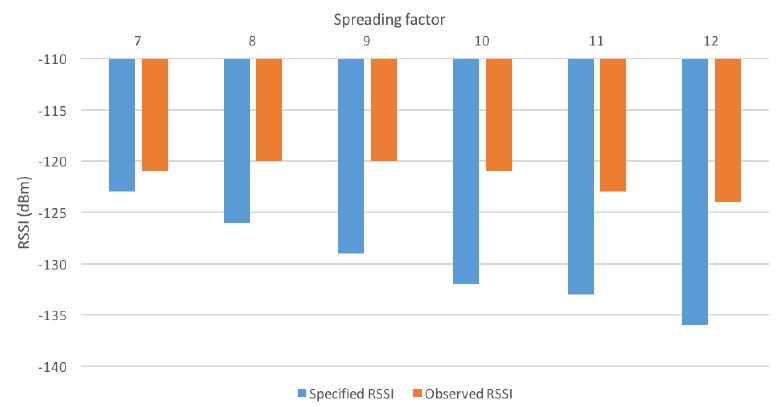
Figure 5. Minimal observed RSSIs with different spreading